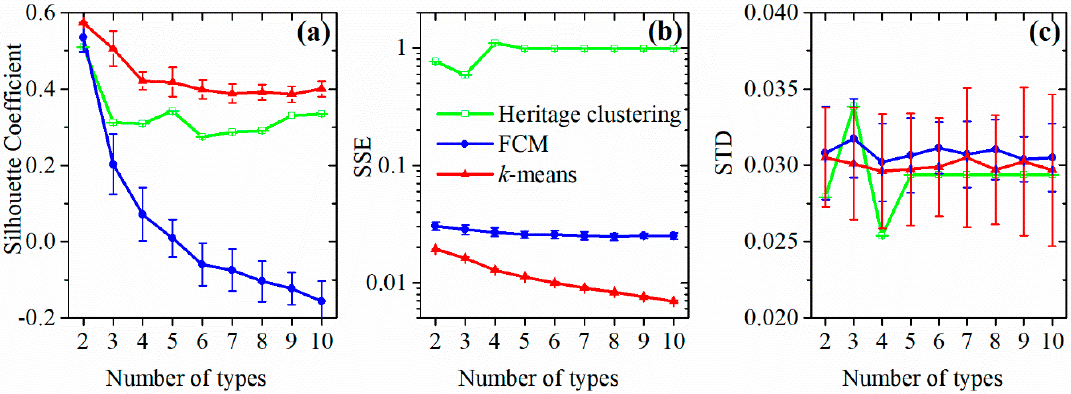
Figure 3. Performance of the three unsupervised clustering methods: heritage clustering, fuzzy c -means (FCM), and k -means in clustering waters with different number of types: ( a ) silhouette coefficient, ( b ) SSE (sum of the squared errors), and ( c ) STD (standard deviation).